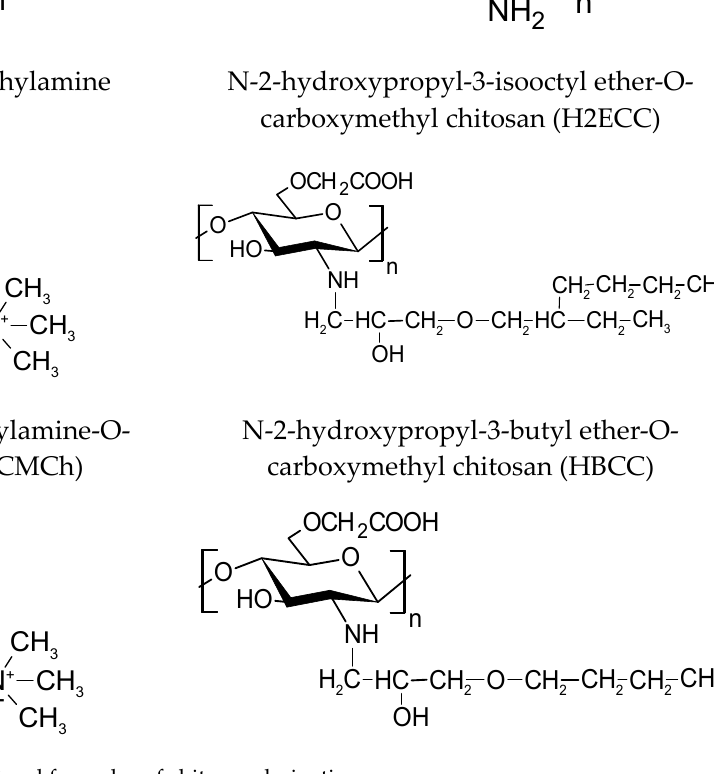
Figure 14. Structural formulas of chitosan derivatives. Table 4. The average induction time of hydrate formation in a methane–water system with 0.1 wt% chitosan at 1 °C, 6 MPa, and 400 rpm.